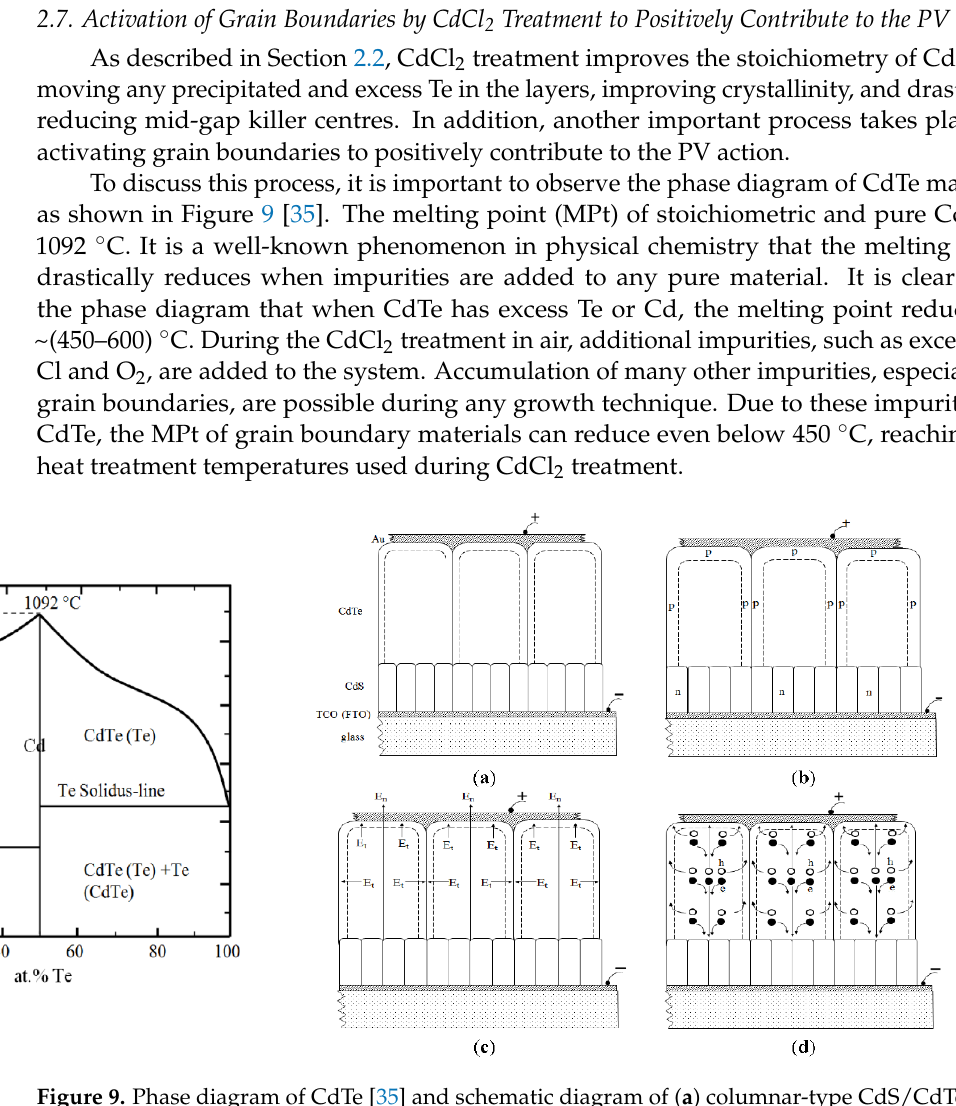
Figure 8. Typical variation in the PEC signal for CdCl 2 -treated CdTe is shown in RED in each panel to separate the p-type and n-type regions. The intensity of the dominant (111) XRD peak is shown in the first panel, indicating the best crystallinity at around V i = 1368 mV on the Cd-rich side. The device parameters for glass/FTO/CdS/CdTe/Au solar cells fabricated with CdTe layers grown in the vicinity of the transition voltage, V i , are shown in the other four panels. Note that all device param- eters are higher when the CdTe layers are rich in Cd and n-type in electrical conduction [34].